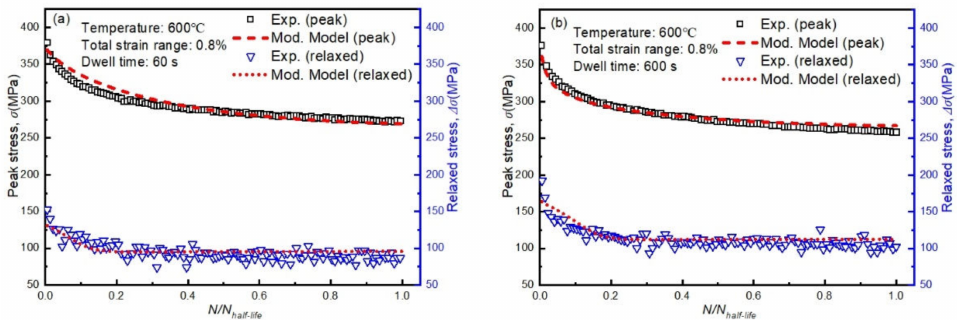
Figure 10. Comparison of simulated peak stress and relaxed stress by modified model and experimental results at 0.8% total strain range at 600 ◦ C with two di ff erent dwell times, ( a ) 60 s and ( b ) 600